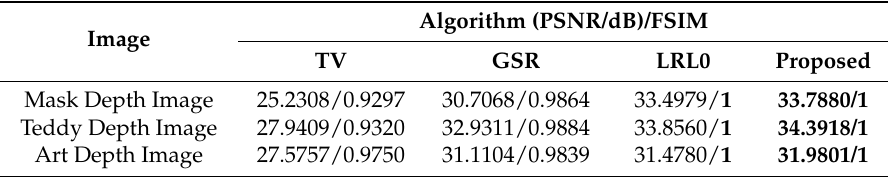
Table 2. PSNR and FSIM result in Experiment